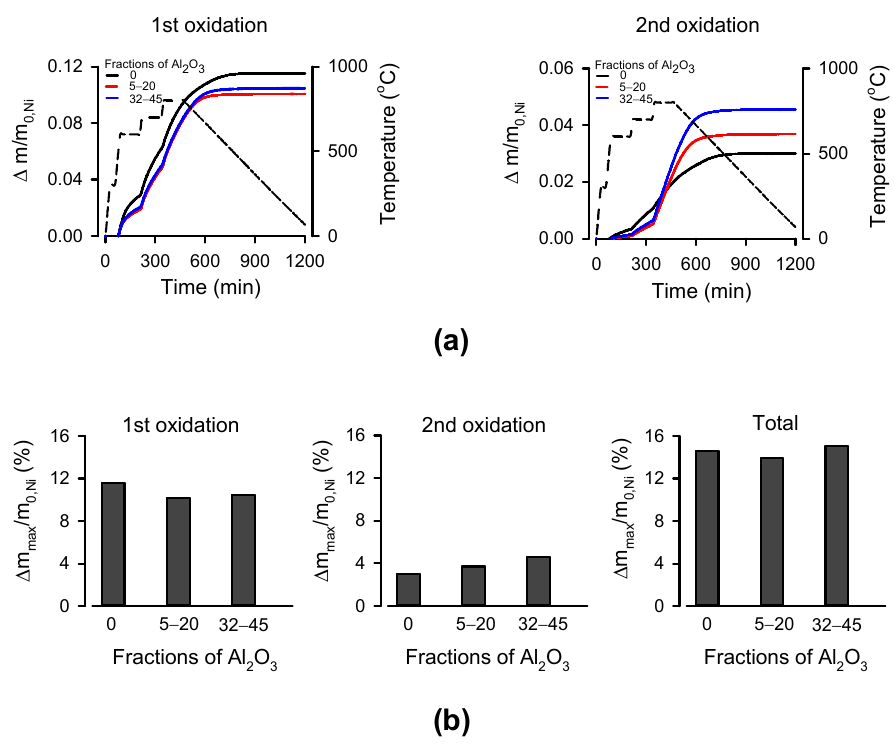
Figure 4. Relative weight gain of oxidized samples. ( a ) Ni (black line), Ni with Al 2 O 3 particles with a diameter of 5–20 μ m (red line), and Ni with Al 2 O 3 particles with a diameter of 32–45 μ m (blue line) during heating in air (dashed line); ( b ) The final relative weight gain after the first and second cycles and a summary after two oxidation cycles.